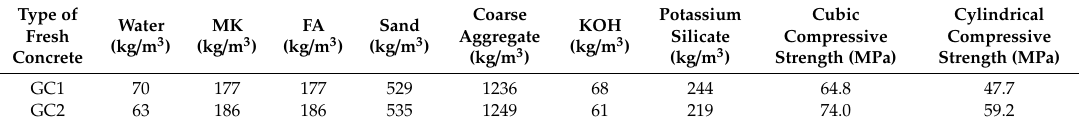
Table 3. Mix proportions and compressive strength of fresh geopolymer